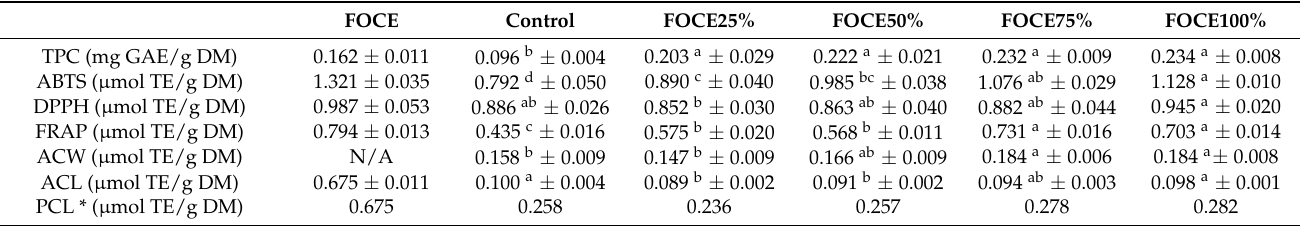
Table 3. The total phenolic content (mg GAE/g DM) and antioxidant capacity ( µ mol TE/g DM) of FOCE and gluten-free breads with